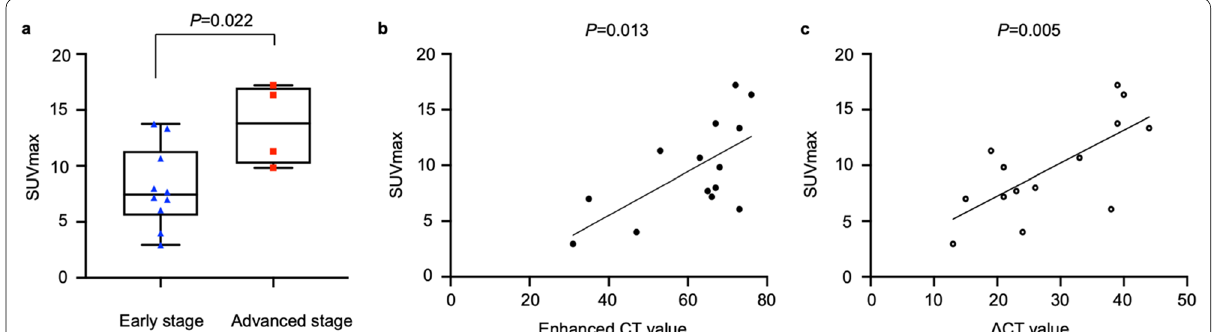
Fig. 7 The difference in SUVmax between early and advanced stages of PAS ( a , P r 0.645, P 0.013) or ΔCT ( d , r = =